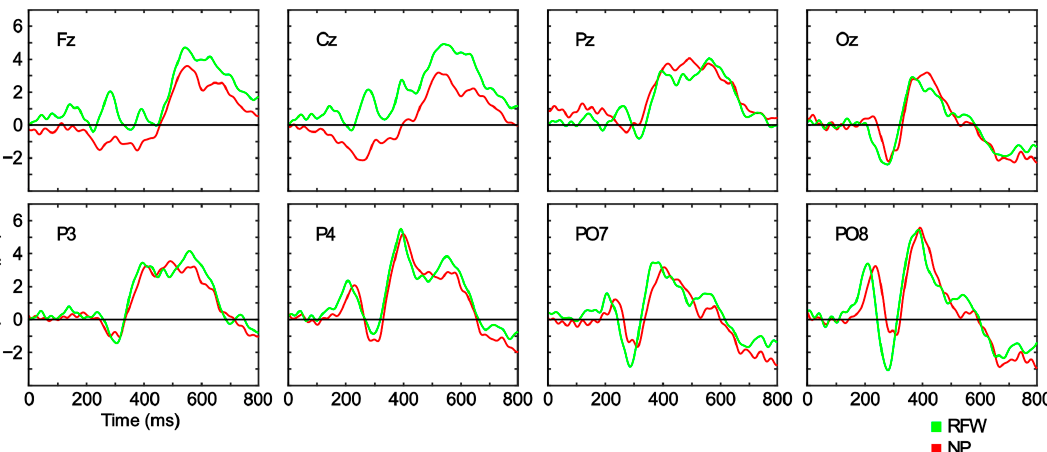
Figure 4. Grand average event ‐ related potential (ERP) waveforms for the amplitude differences ( μ V) between the target and non ‐ target stimuli for each condition (red faces surrounded by a white rectangle (RFW) and neutral pictures (NP)) and channel (Fz, Cz, Pz, Oz, P3, P4, PO7, and PO8), represented over the time interval from 0 to 800 ms. No significant differences were found between the target and non ‐ target stimuli for any of the channels.